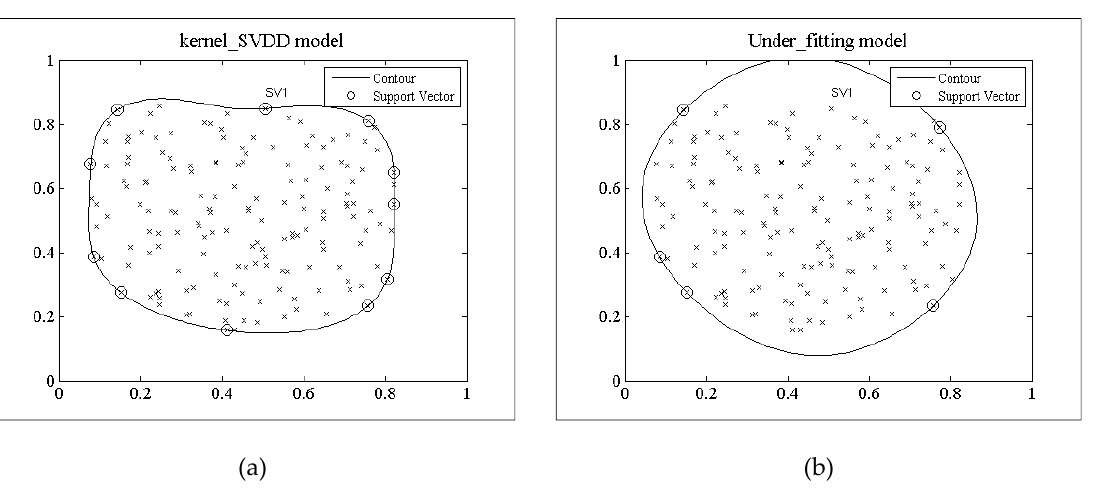
Figure 3. Under-fitting model ( a ) Model trained by kernel_SVDD; ( b ) Model trained by TRFF.